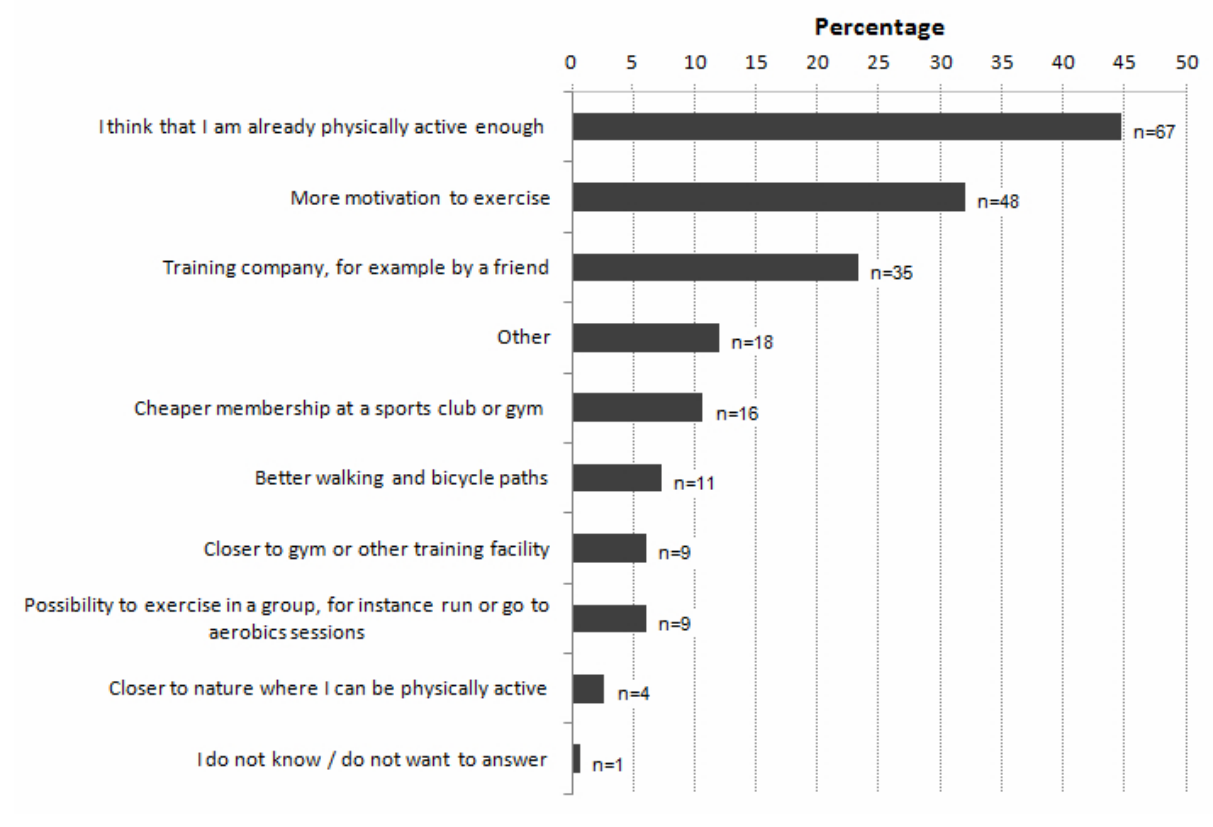
Figure 3. Incentives that would make the participants more physically active (n=150). The 18 men answering “Other” received a follow-up question with the possibility to write down what would make them more physically active. Eight of the men answered less pain during exercise and six needed more leisure time.